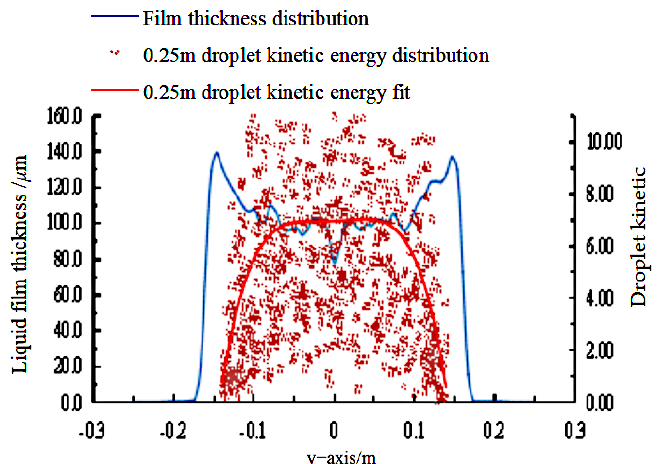
Figure 27. Comparison of liquid film thickness and droplet kinetic energy distribution.